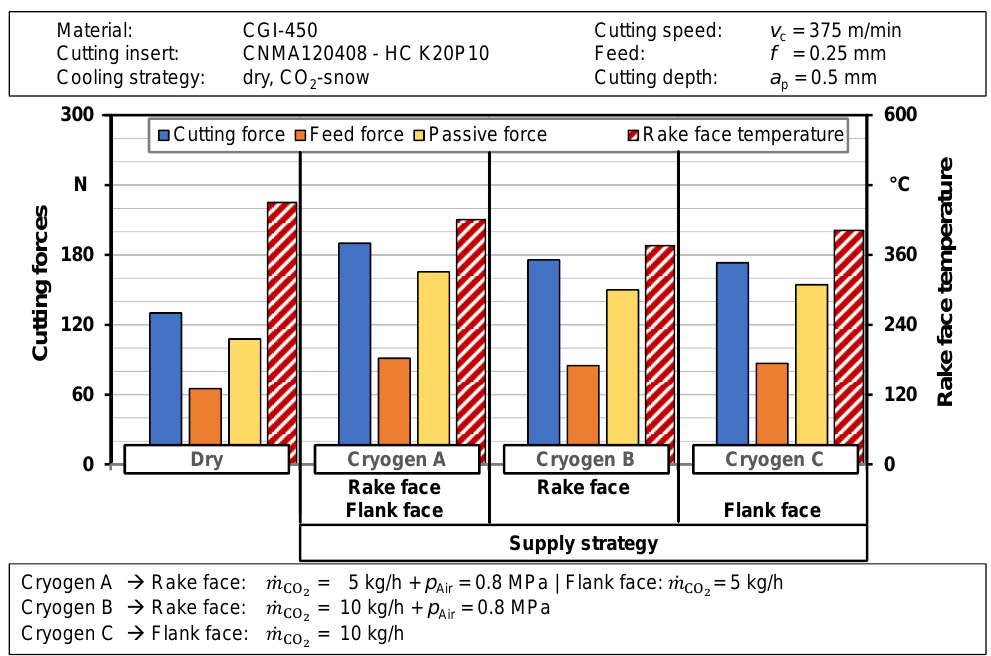
Figure 6. Thermomechanical tool load using sharp cutting inserts with different cooling strategies compared to dry machining.